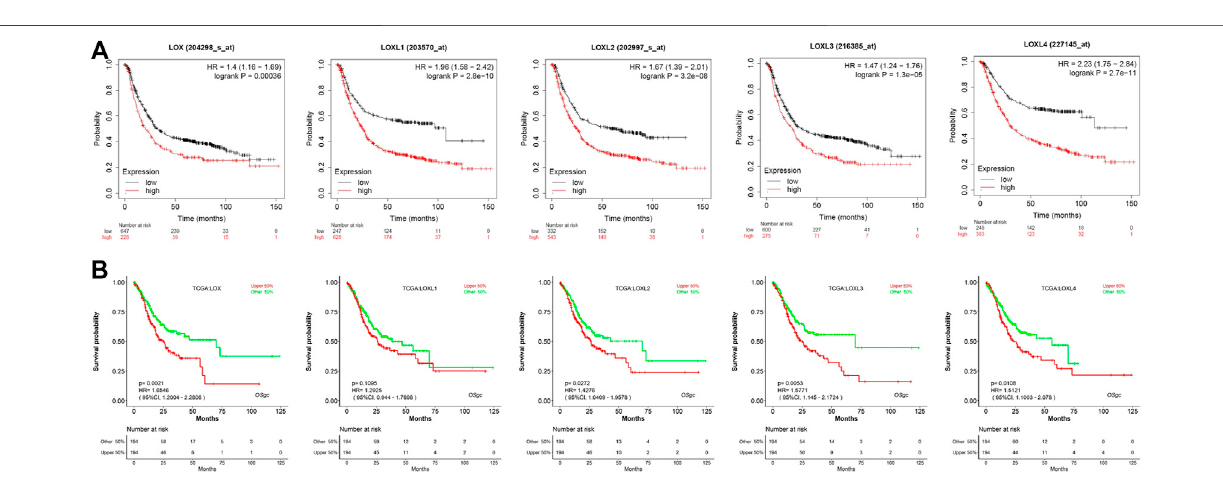
Frontiers in Genetics |